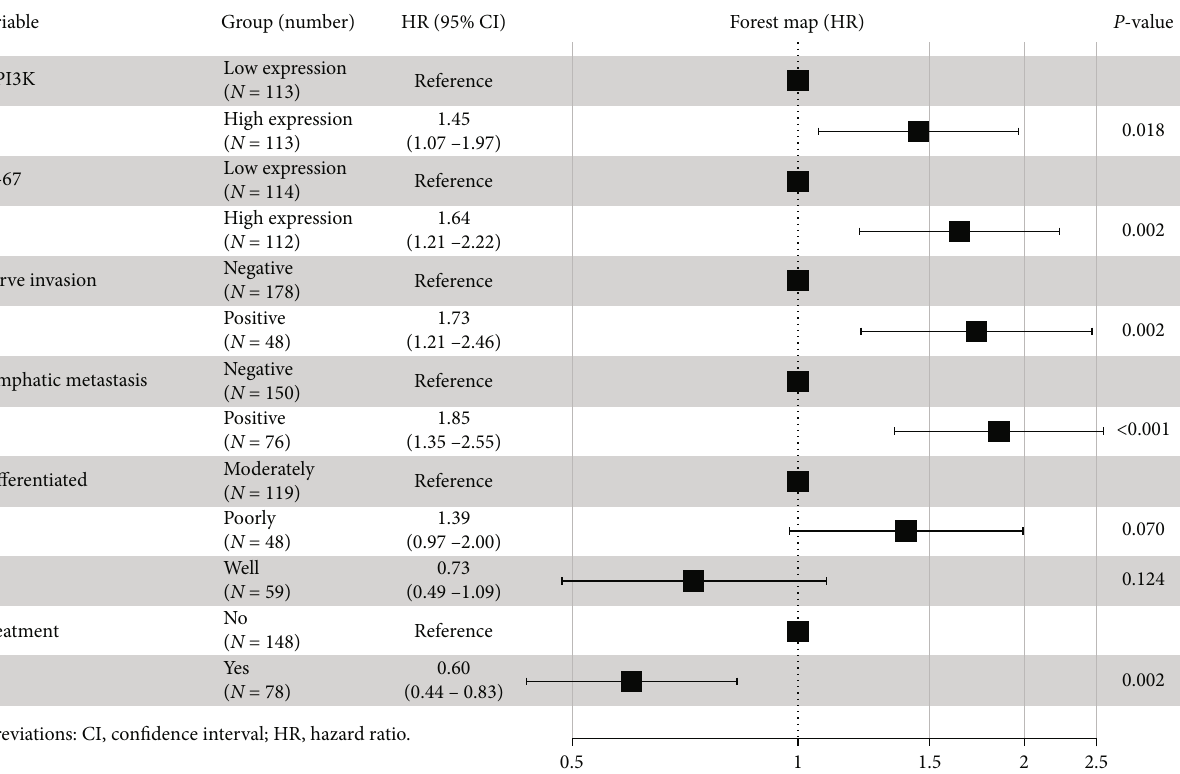
Figure 8: Multivariate analysis and forest maps. High expression of p-PI3K, high expression of Ki-67, nerve invasion, and lymphatic metastasis were independent risk factors for ESCC patients; treatment was an independent protective factor in ESCC